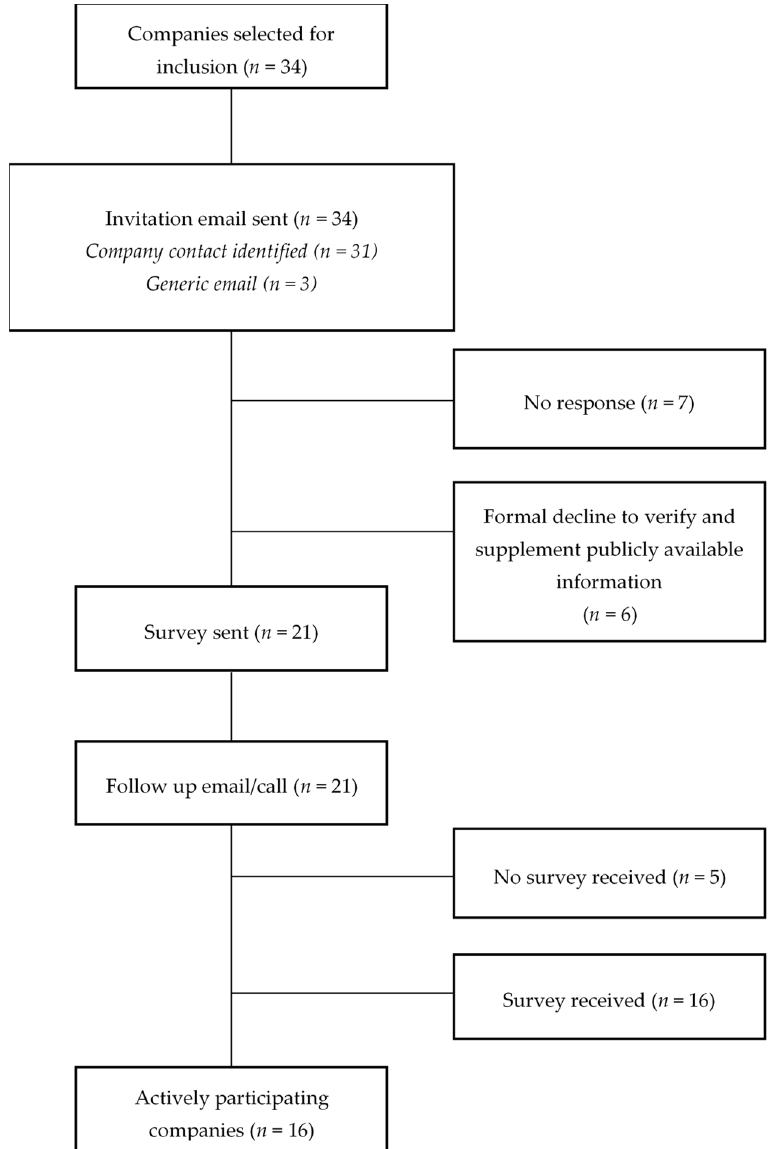
Figure 1. Participant flow diagram showing the levels of engagement of the companies included in BIA-Obesity Australia 2018 .